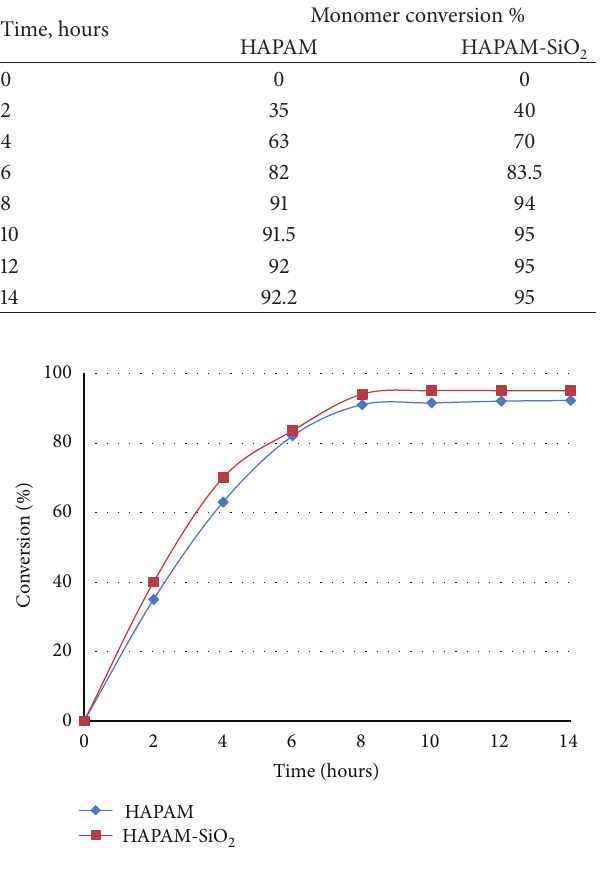
Table 9: Monomer conversion rate with time.